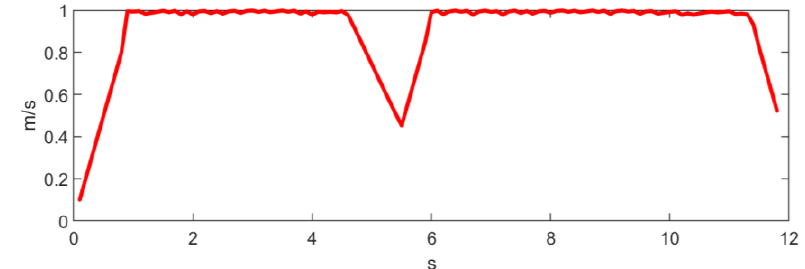
Figure 14. Linear velocity generated in the long wall scenario.